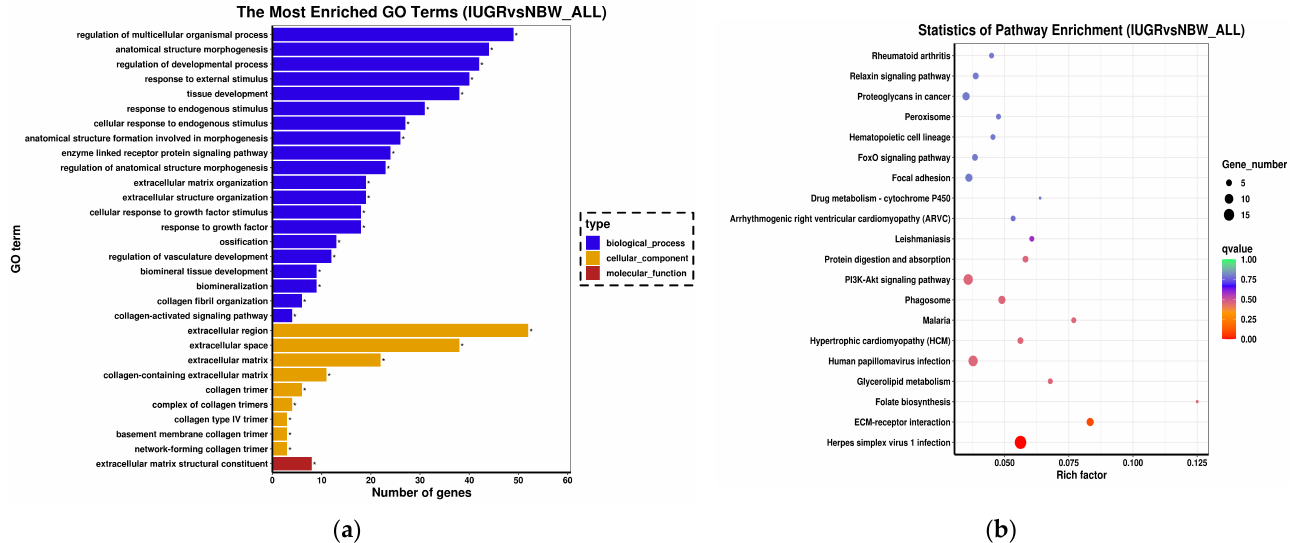
Figure 3. Enrichment Analysis. ( a ) GO term enrichment analysis of DEGs, with the 30 top terms obtained by GO enrichment. The x -axis represents the number of DEGs in the term, and the y -axis represents the enriched GO terms. The top 30 GO terms included 20 terms for biological process, 9 terms for cellular component and 1 term for molecular function. “*” indicates p < 0.05. ( b ) Enriched KEGG pathways (top 20) for the DEGs that were obtained by KEGG enrichment. The size of the dots indicates the number of expressed genes in the pathway, and the color of the dots represents the different Q value ranges of the pathway.